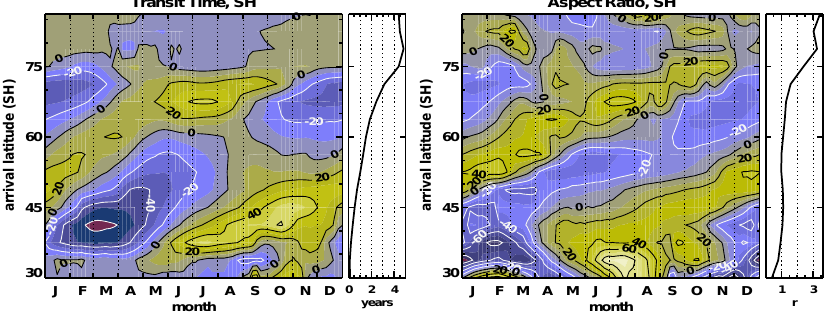
Fig. 8. Same as Fig. 7 but for southern hemispheric extratropics.